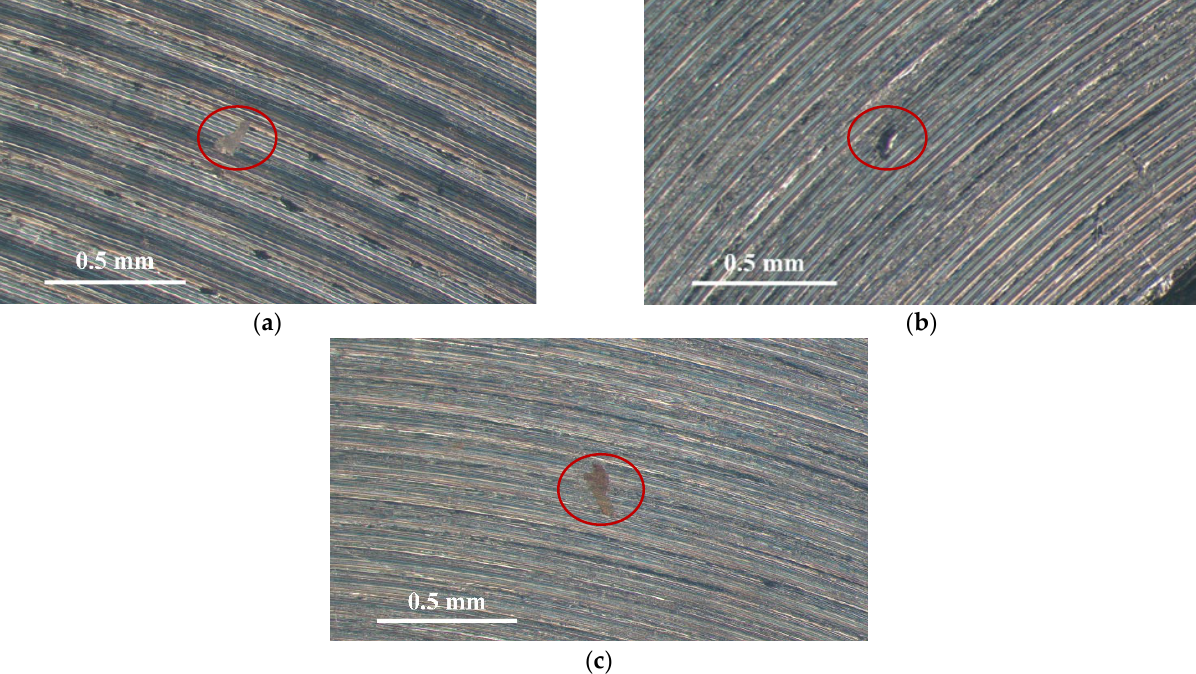
Figure 5. Macrographs of the corrosion regions of those samples with a 0.1 g/m 2 chloride concentration at: ( a ) Relative humidity = 45%, ( b ) relative humidity = 55%, and ( c ) relative humidity = 70%.